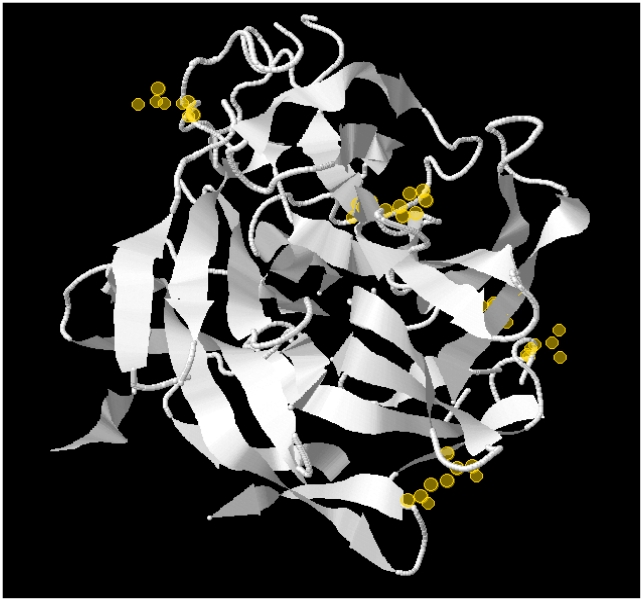
Predicted protein structure of β-xylosidase of M. graminicola.Note that the amino acid sites under positive diversifying selection (yellow halos) are located on the surface of the protein.